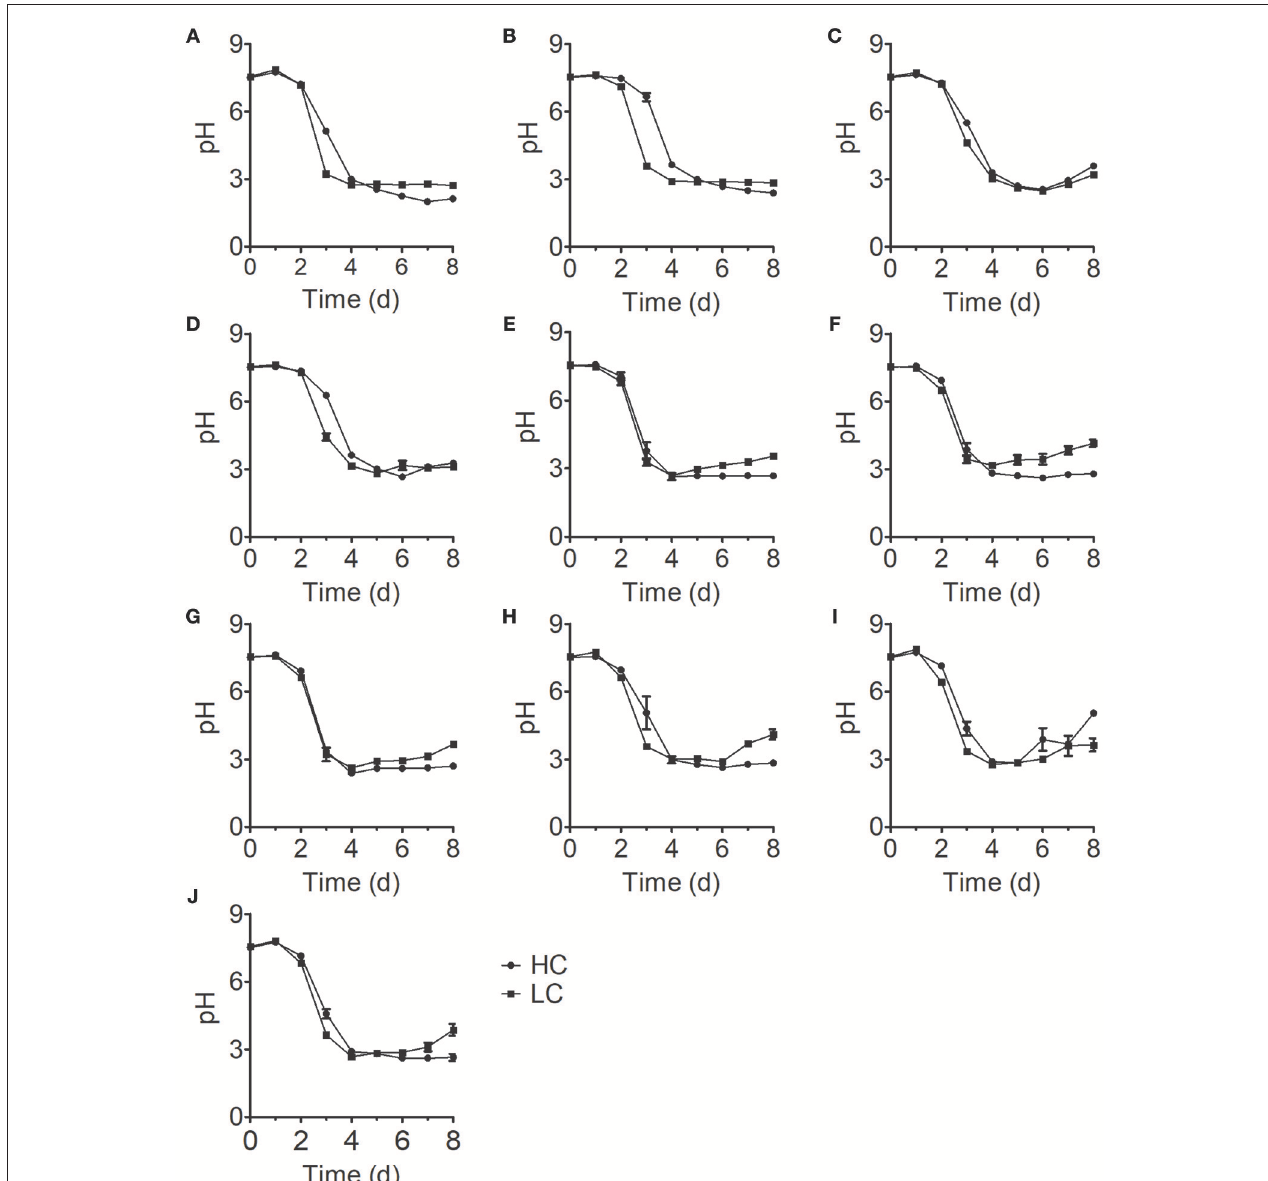
FIGURE 3 | pH changes in 10 Chlorella strains cultivated in HC (circles) and LC (squares) medium. (A–J) Represent Chlorella strain FACHB-1, FACHB-1216, FACHB-1535, FACHB-1563, W1, W2, W3, W4, W5, and W6, respectively.